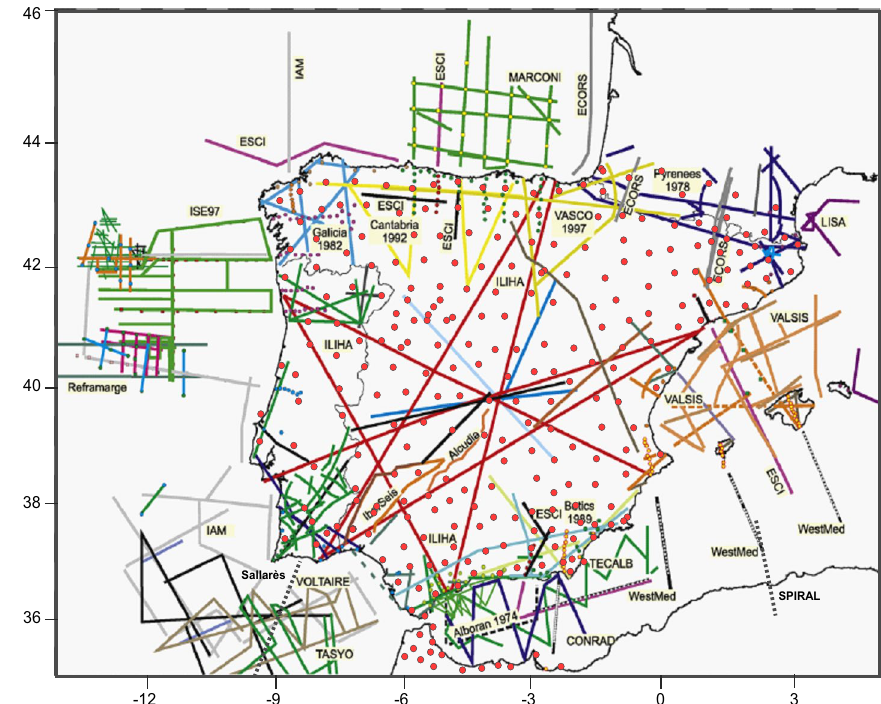
Fig. 2 Location of the seismic experiments carried out on the Iberian Peninsula and its adjacent margins since the early 70s. Red circles show locations of the temporary network of broadband seismic stations. Adapted from Díaz and Gallart (2009)